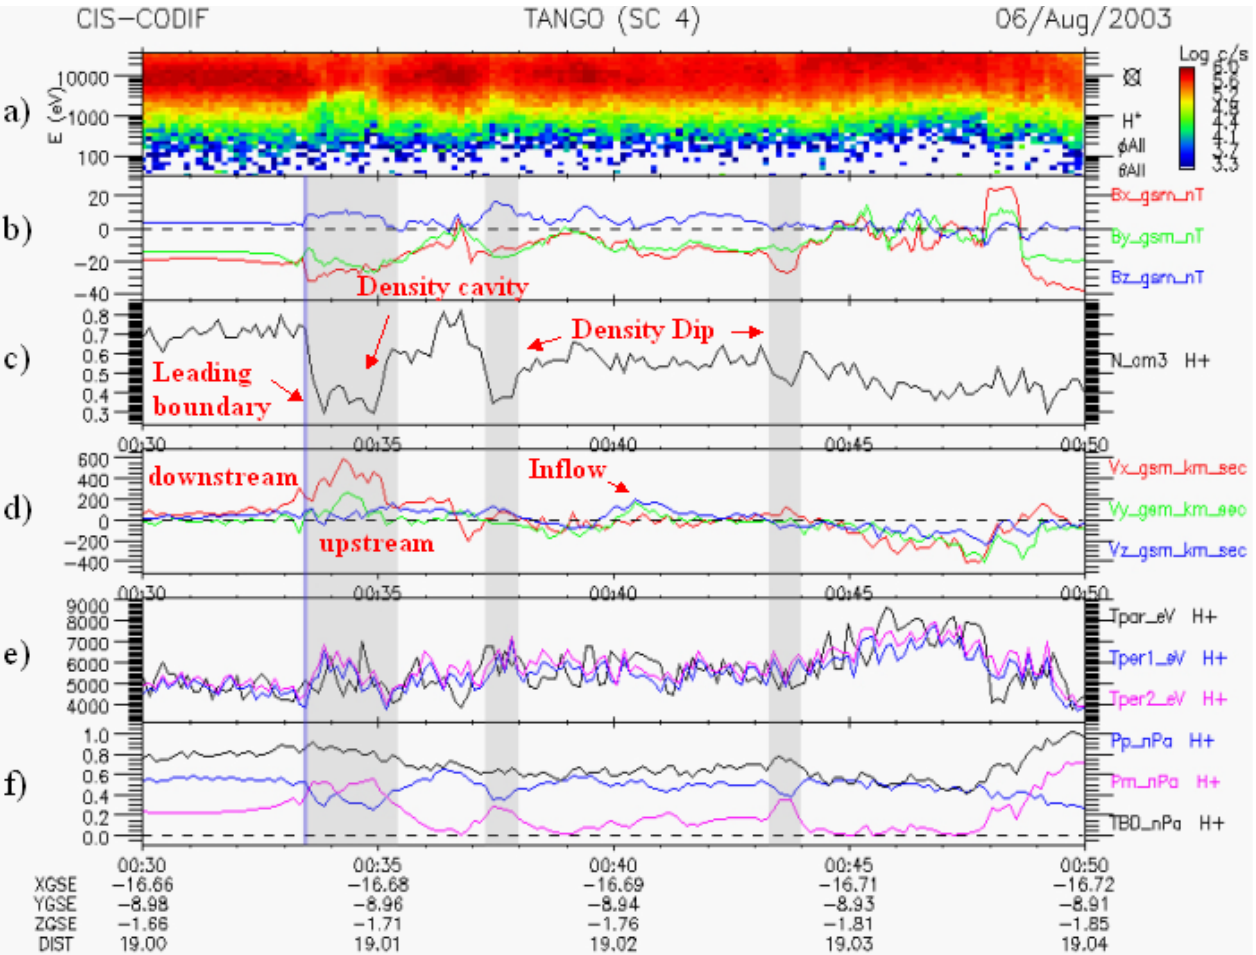
Fig. 1. Magnetic field and proton measurements from C4. From top: (a) time-energy spectrogram, (b) components of magnetic field, (c) and (d) proton density and bulk velocities respectively, (e) proton pressure components parallel and perpendicular to the magnetic field, and (f) magnetic pressure, proton pressure and total pressure respectively. The shadows denote the density cavity and two density dips,